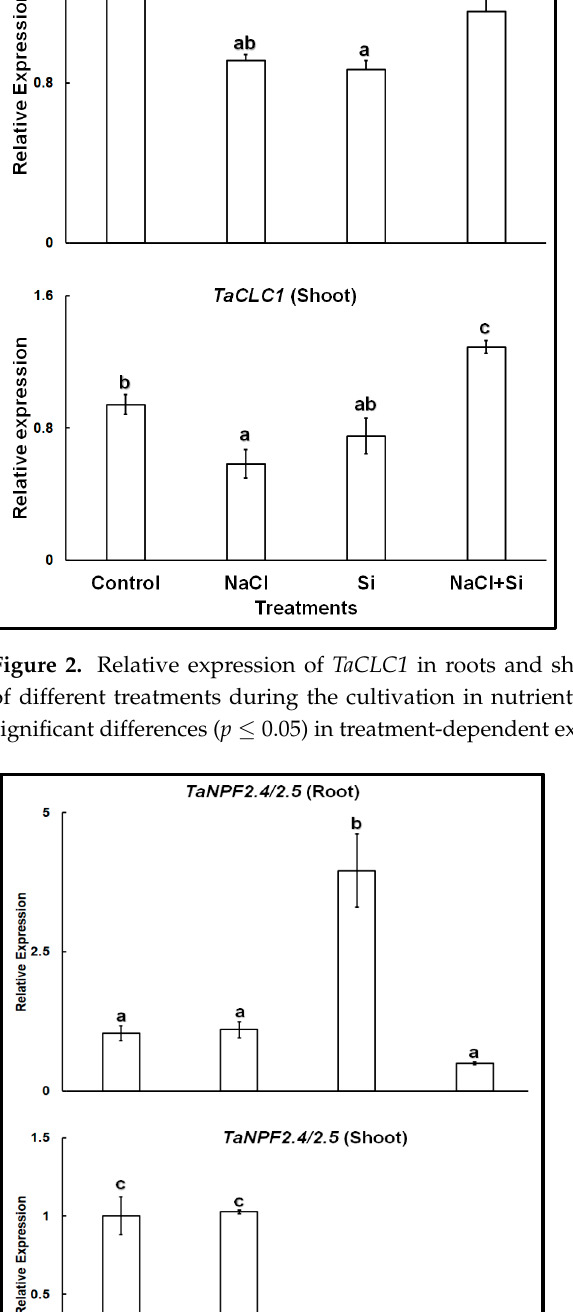
Figure 3. Relative expression of TaNPF2.4/2.5 in roots and shoots of wheat cv. Vinjette after 4 d of different treatments (100 mM NaCl, 1 mM Si or their combination) during cultivation in nutrient solution. Different letters indicate significant difference at p < 0.05 using Tukey’s test.